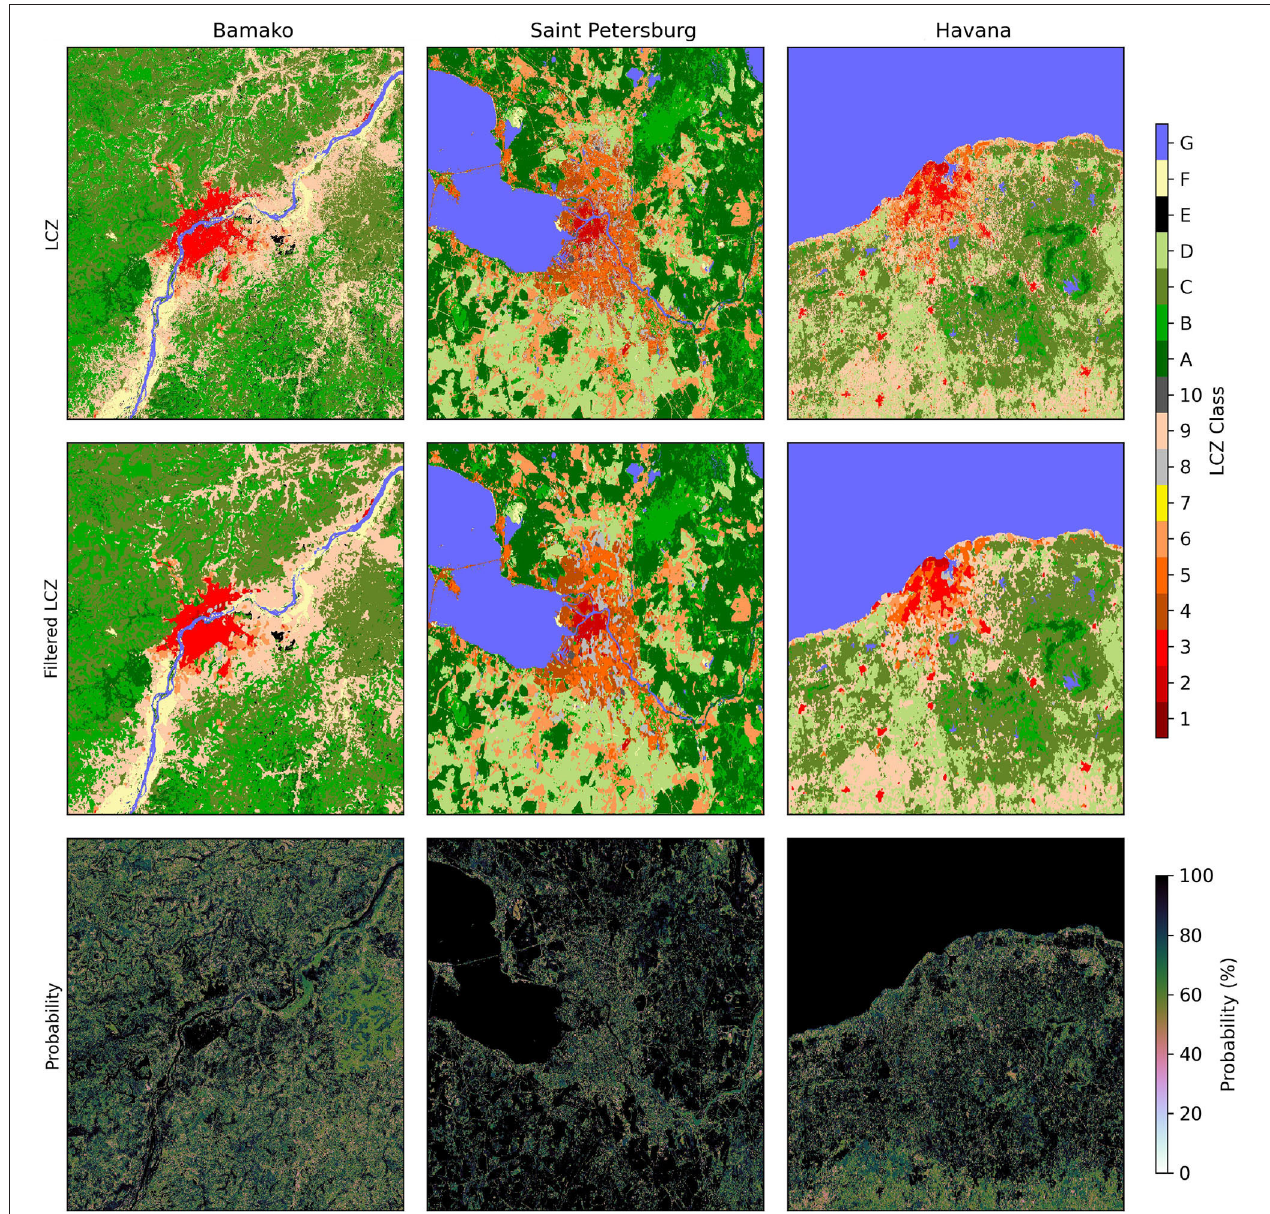
FIGURE 5 | Information contained in the geotif output file, for all cities (columns): final LCZ map (Top) , final filtered LCZ map (Middle) , and probability map (Lower)